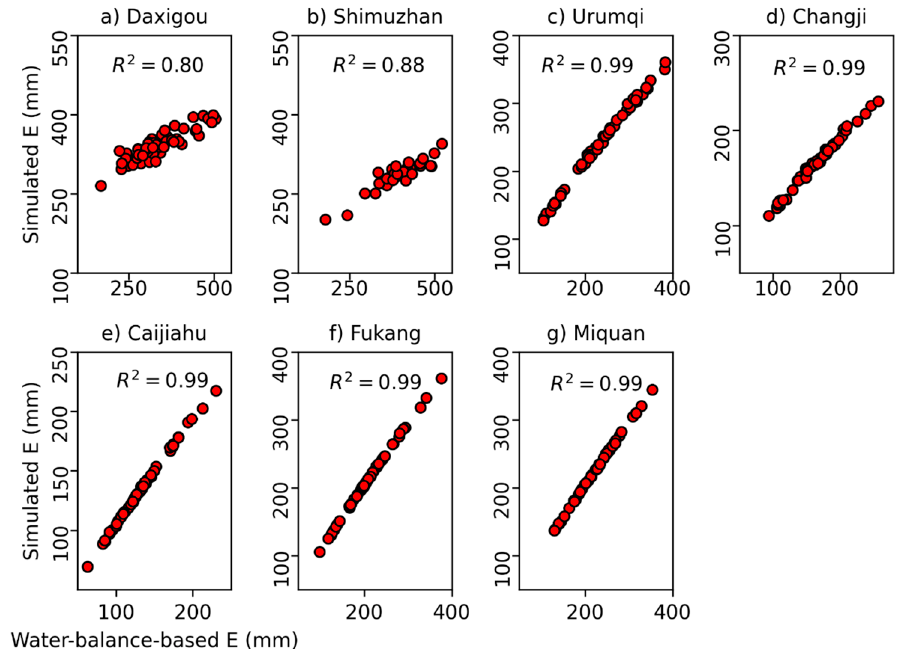
Figure 2. Comparison of the water-balance-based evaporation (x-axis) and simulated evaporation (y-axis) using Budyko framework across the representative climate stations in the basin. Table 2. Simulation accuracy of E and elasticity of runoff to changes in climatic and other factors across the Urumqi River basin.